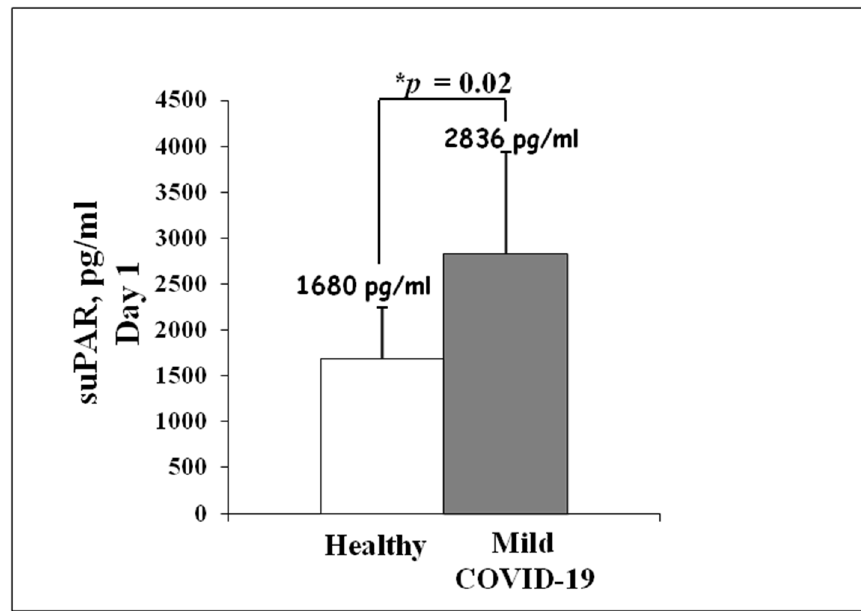
Figure 2. Analysis of serum suPAR levels in mild cases of COVID-19 during Italian second wave. suPAR measurements were performed by ELISA method on serum samples within 24 h of admission to Infectious Disease Unit (grey column). Ten healthy subjects were enrolled as a control (white column). Asterisk indicates statistical significance between healthy control and COVID-19 patients, determined by the Student t-test (* p < 0.05).